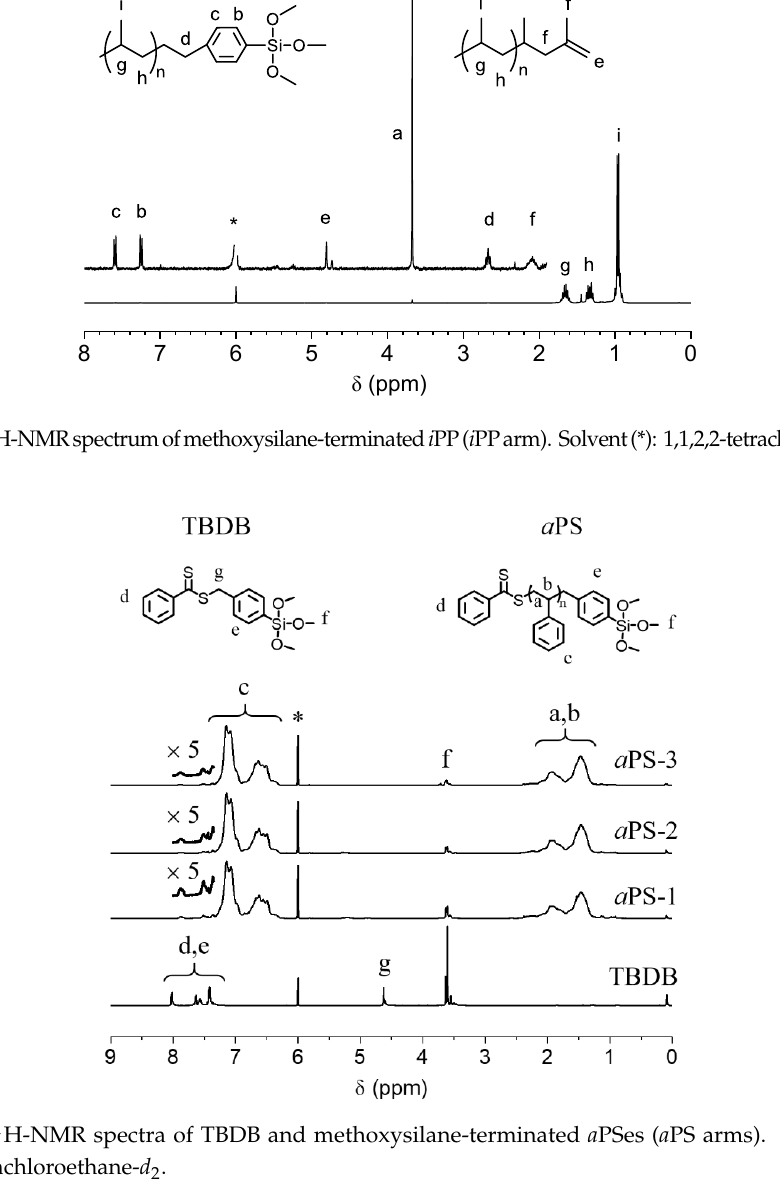
Figure 1. 1 H-NMR spectrum of methoxysilane-terminated i PP ( i PP arm). Solvent (*): 1,1,2,2- tetrachloroethane- d 2 .